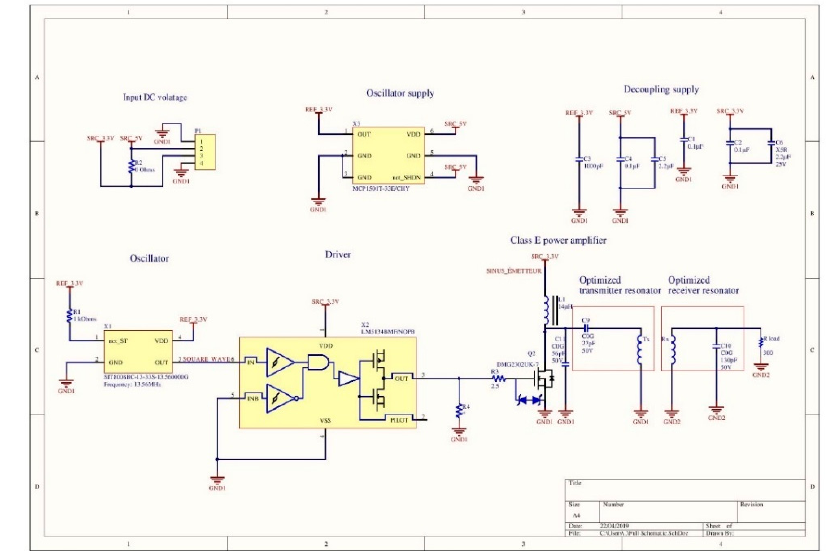
Figure 14. Eclectic design of the proposed near-field RIC WPT system. Table 8. System parameters values.